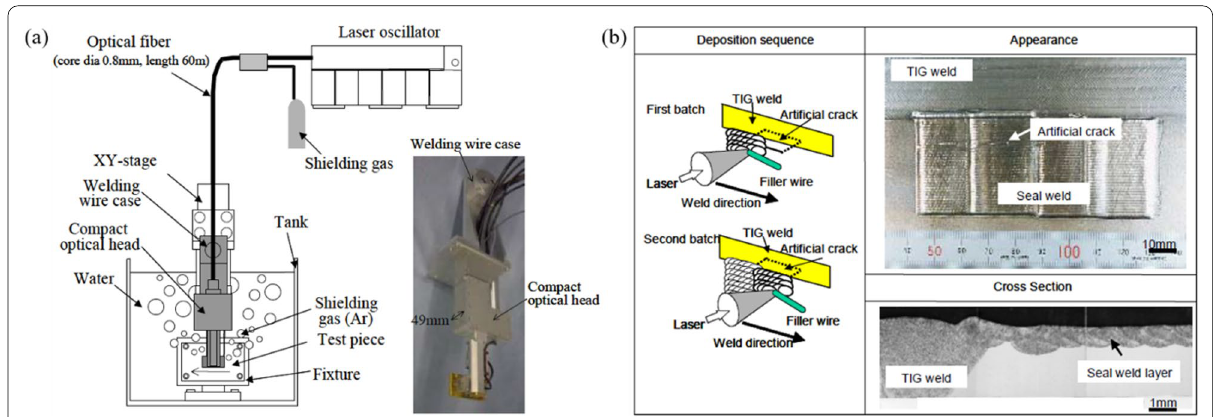
Figure 8 Results from Toshiba in Japan: ( a ) Schematic of experimental setup for laser seal welding and ( b ) deposition sequence and result of mock-up test of laser seal welded 304L stainless steel [37]